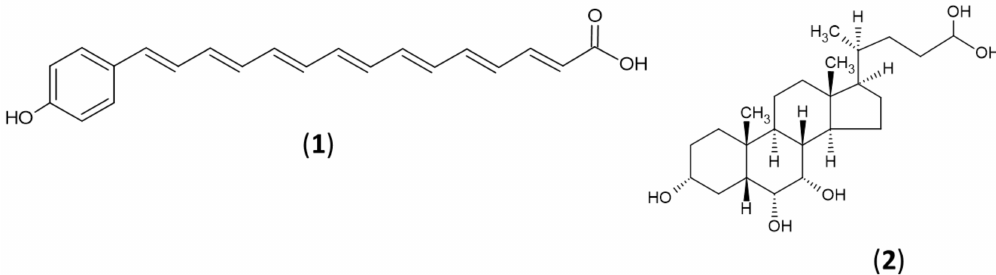
Figure 5. Arylpolyene ( 1 ) and cholyglycine ( 2 ) compounds detected in the Streptomyces sp.